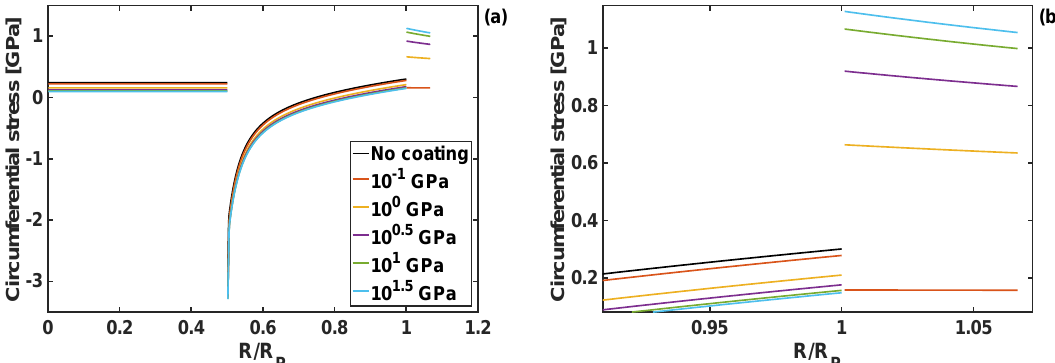
Figure 4: (a) Circumferential stress component as a function of normalised particle radius for different shear moduli, and h=10 nm and K T =1 GPa; (b) zoom-in on the circumferential stresses close to the edge of the particle and within the coating.